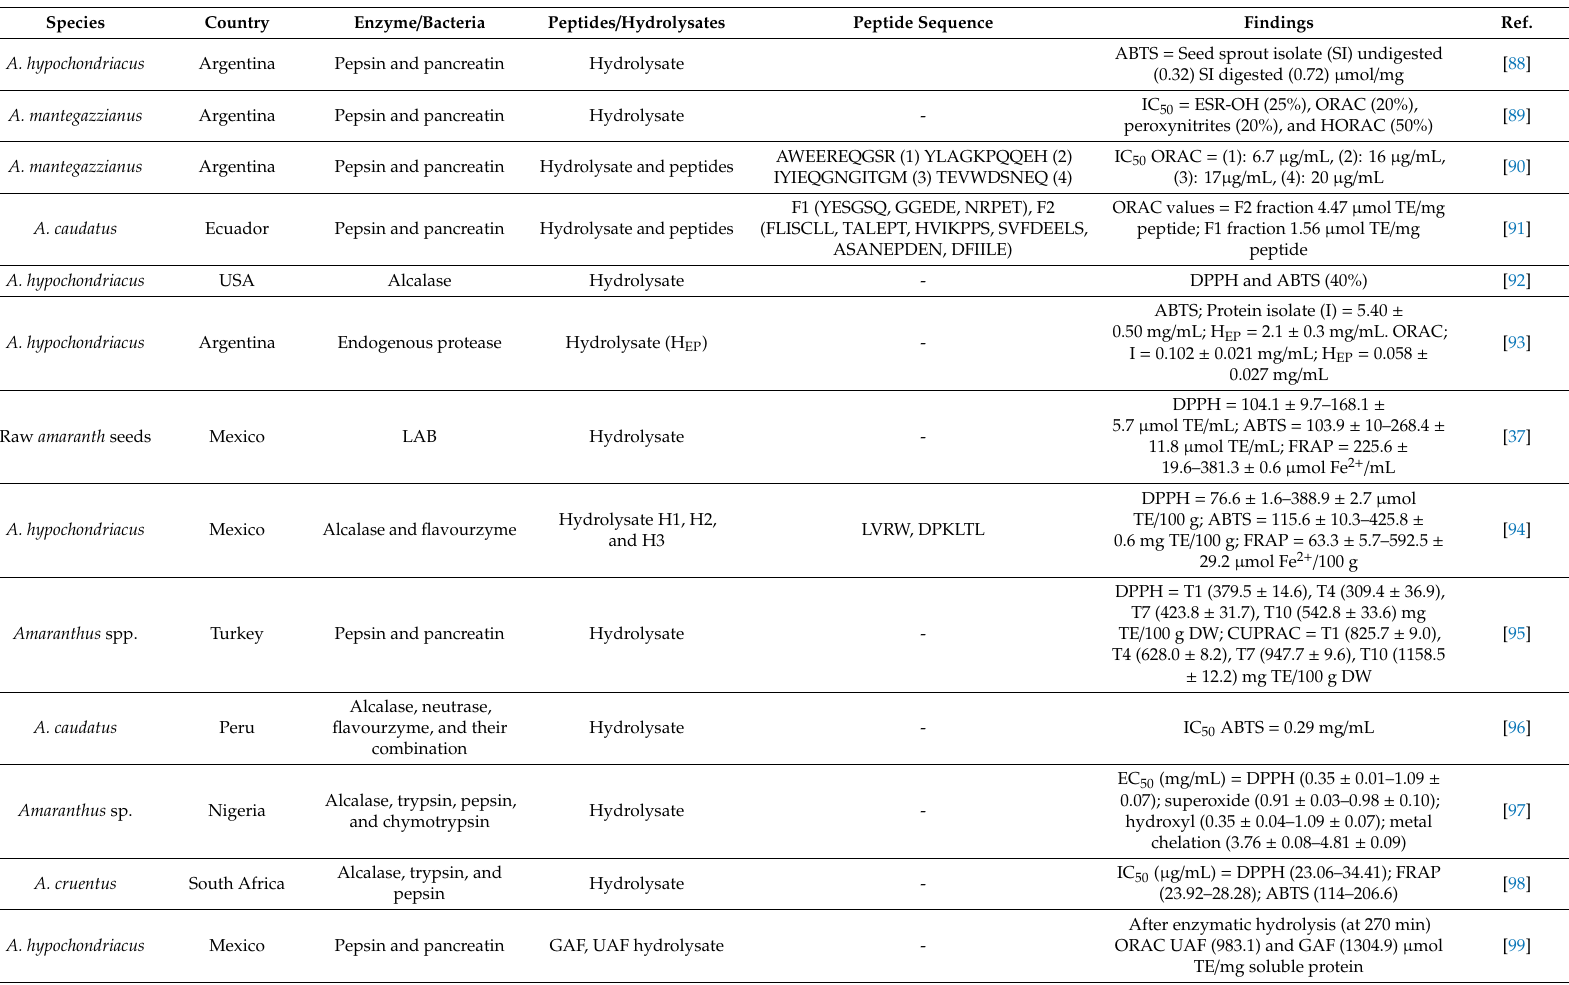
Table 4. Antioxidant activity of hydrolysates and peptides derived from various Amaranthus